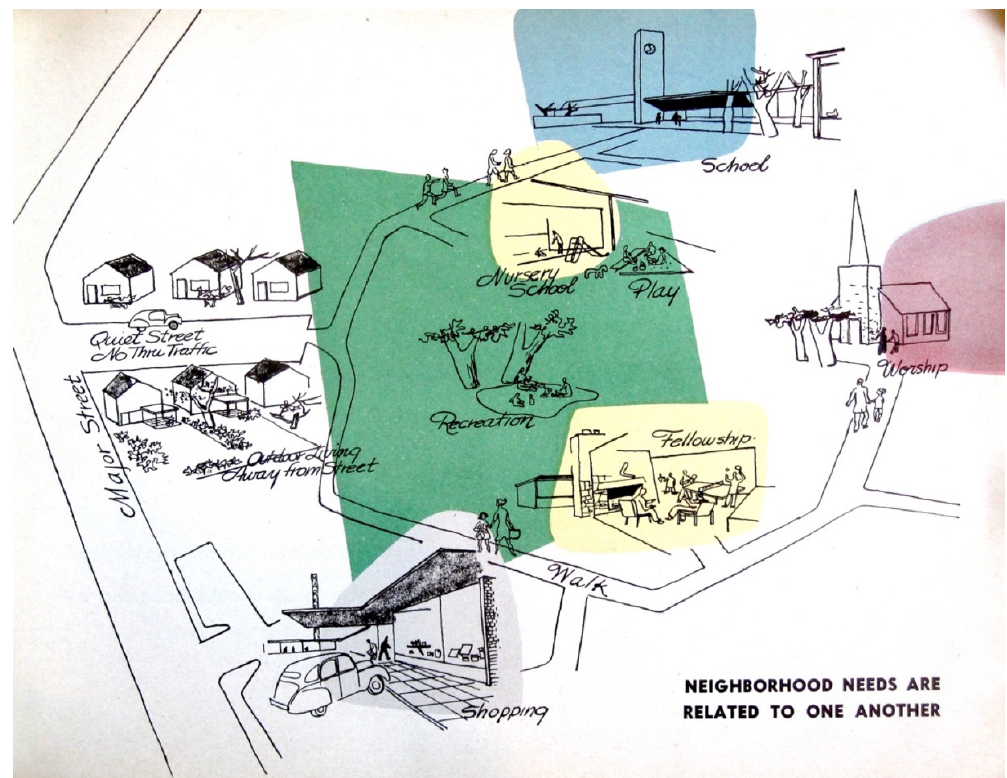
Figure 8. Diagrams representing neighborhood needs from You and Your Neighborhood . Source: Stonorov and Kahn (1944). and epitomized by the experimental community plan‐